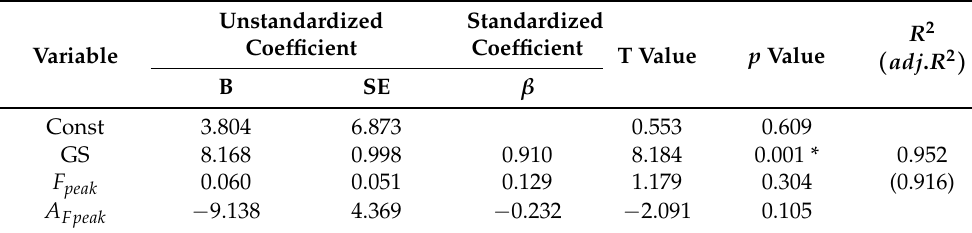
Table 6. Factors related to the realism rating of the removal of hardness (multivariate analysis).